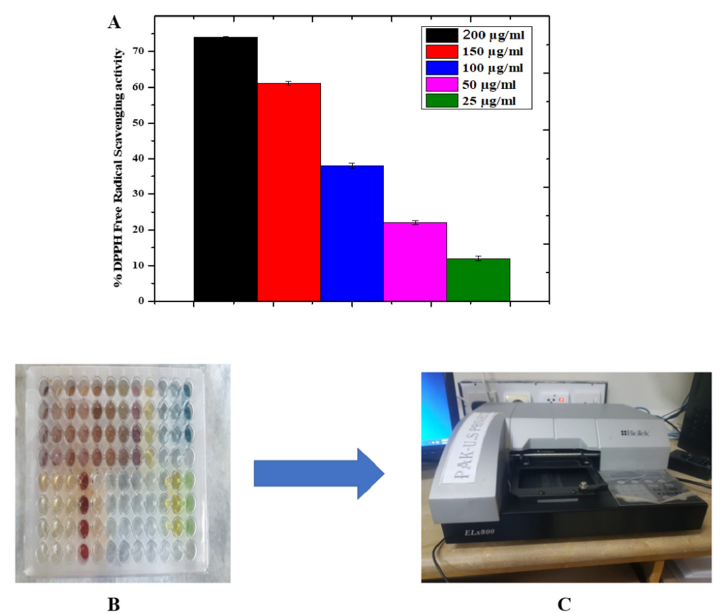
Figure 5. ( A ) Antioxidant potential of biosynthesized MnO 2 NPs, ( B ) Test solution in the 96-well plates and ( C ) microplate reader.